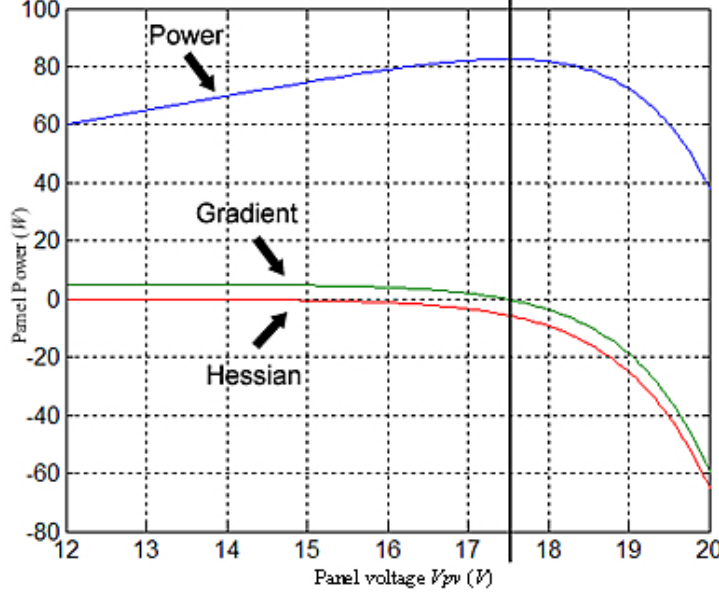
Figure 6. Voltage-power characteristic of a panel